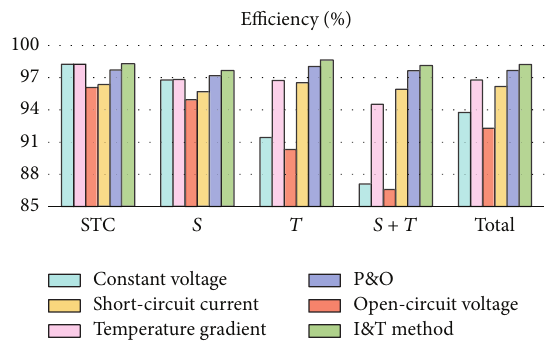
Figure 12: Efficiency of MPPT techniques considering both irradiance and temperature variation.